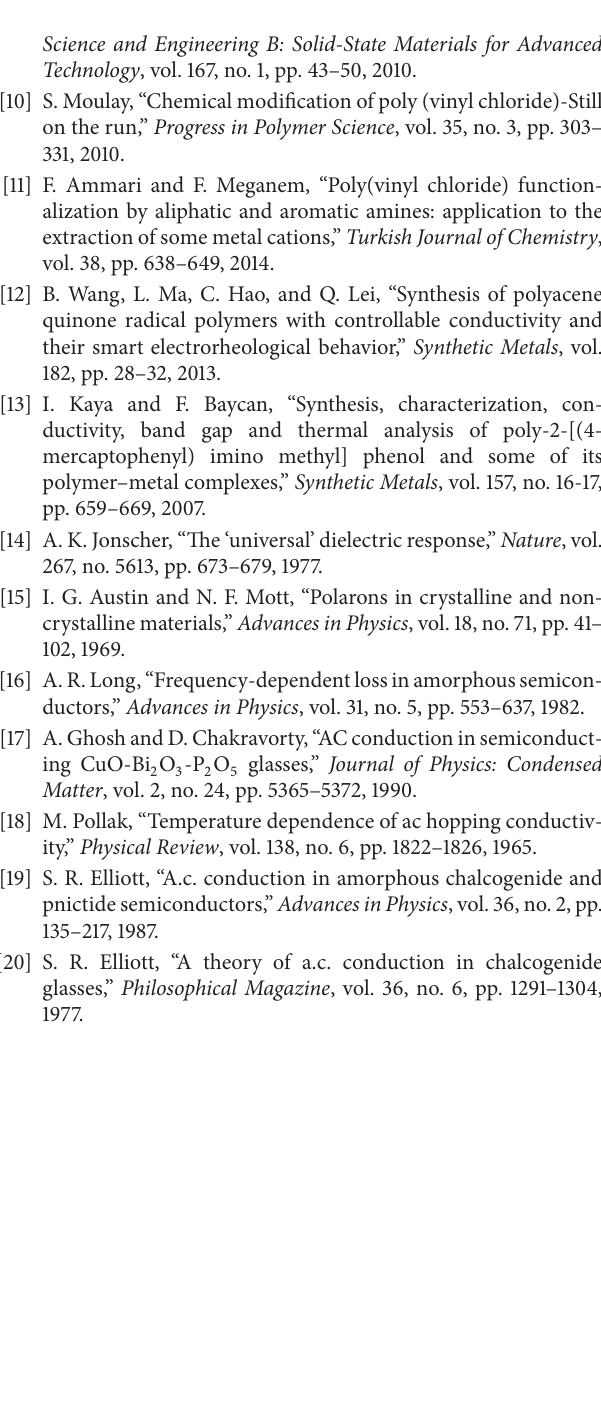
Table 1: Power exponent of the polymer (P